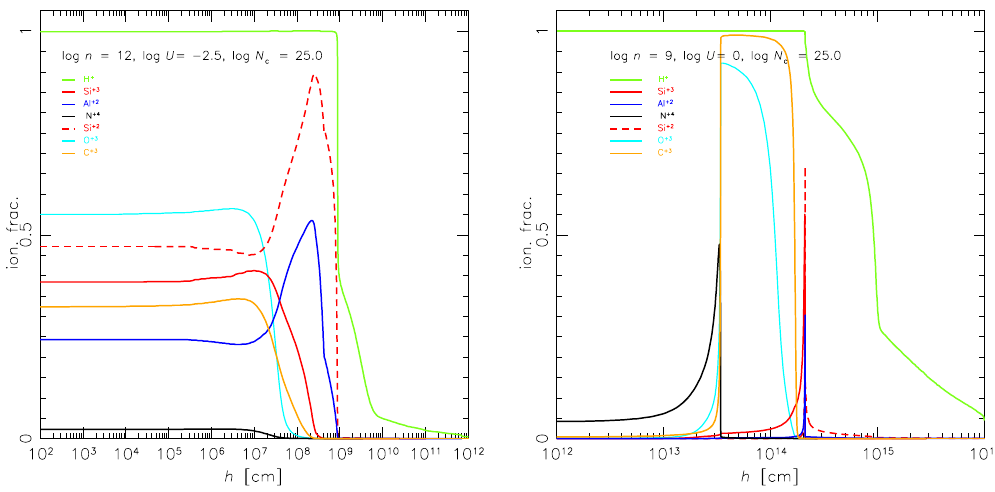
Figure 6. Ionization degree as a function of depth h in the illuminated slab of emitting gas, exposed from the left side to the radiation field. Left panel: low ionization case; right panel: high ionization case. Electron-ion collisions are expected to be the dominant contributor to optically thick resonance lines. For log N c = 23 (cm − 2 ) and Z (cid:38) 1 Z (cid:12) , all lines considered here are optically thick, with